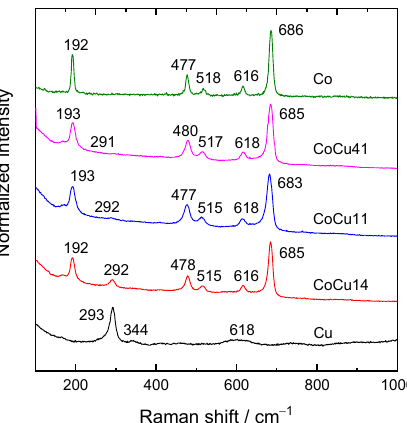
Figure 2. Raman spectra of the examined Co-Cu oxide catalysts.